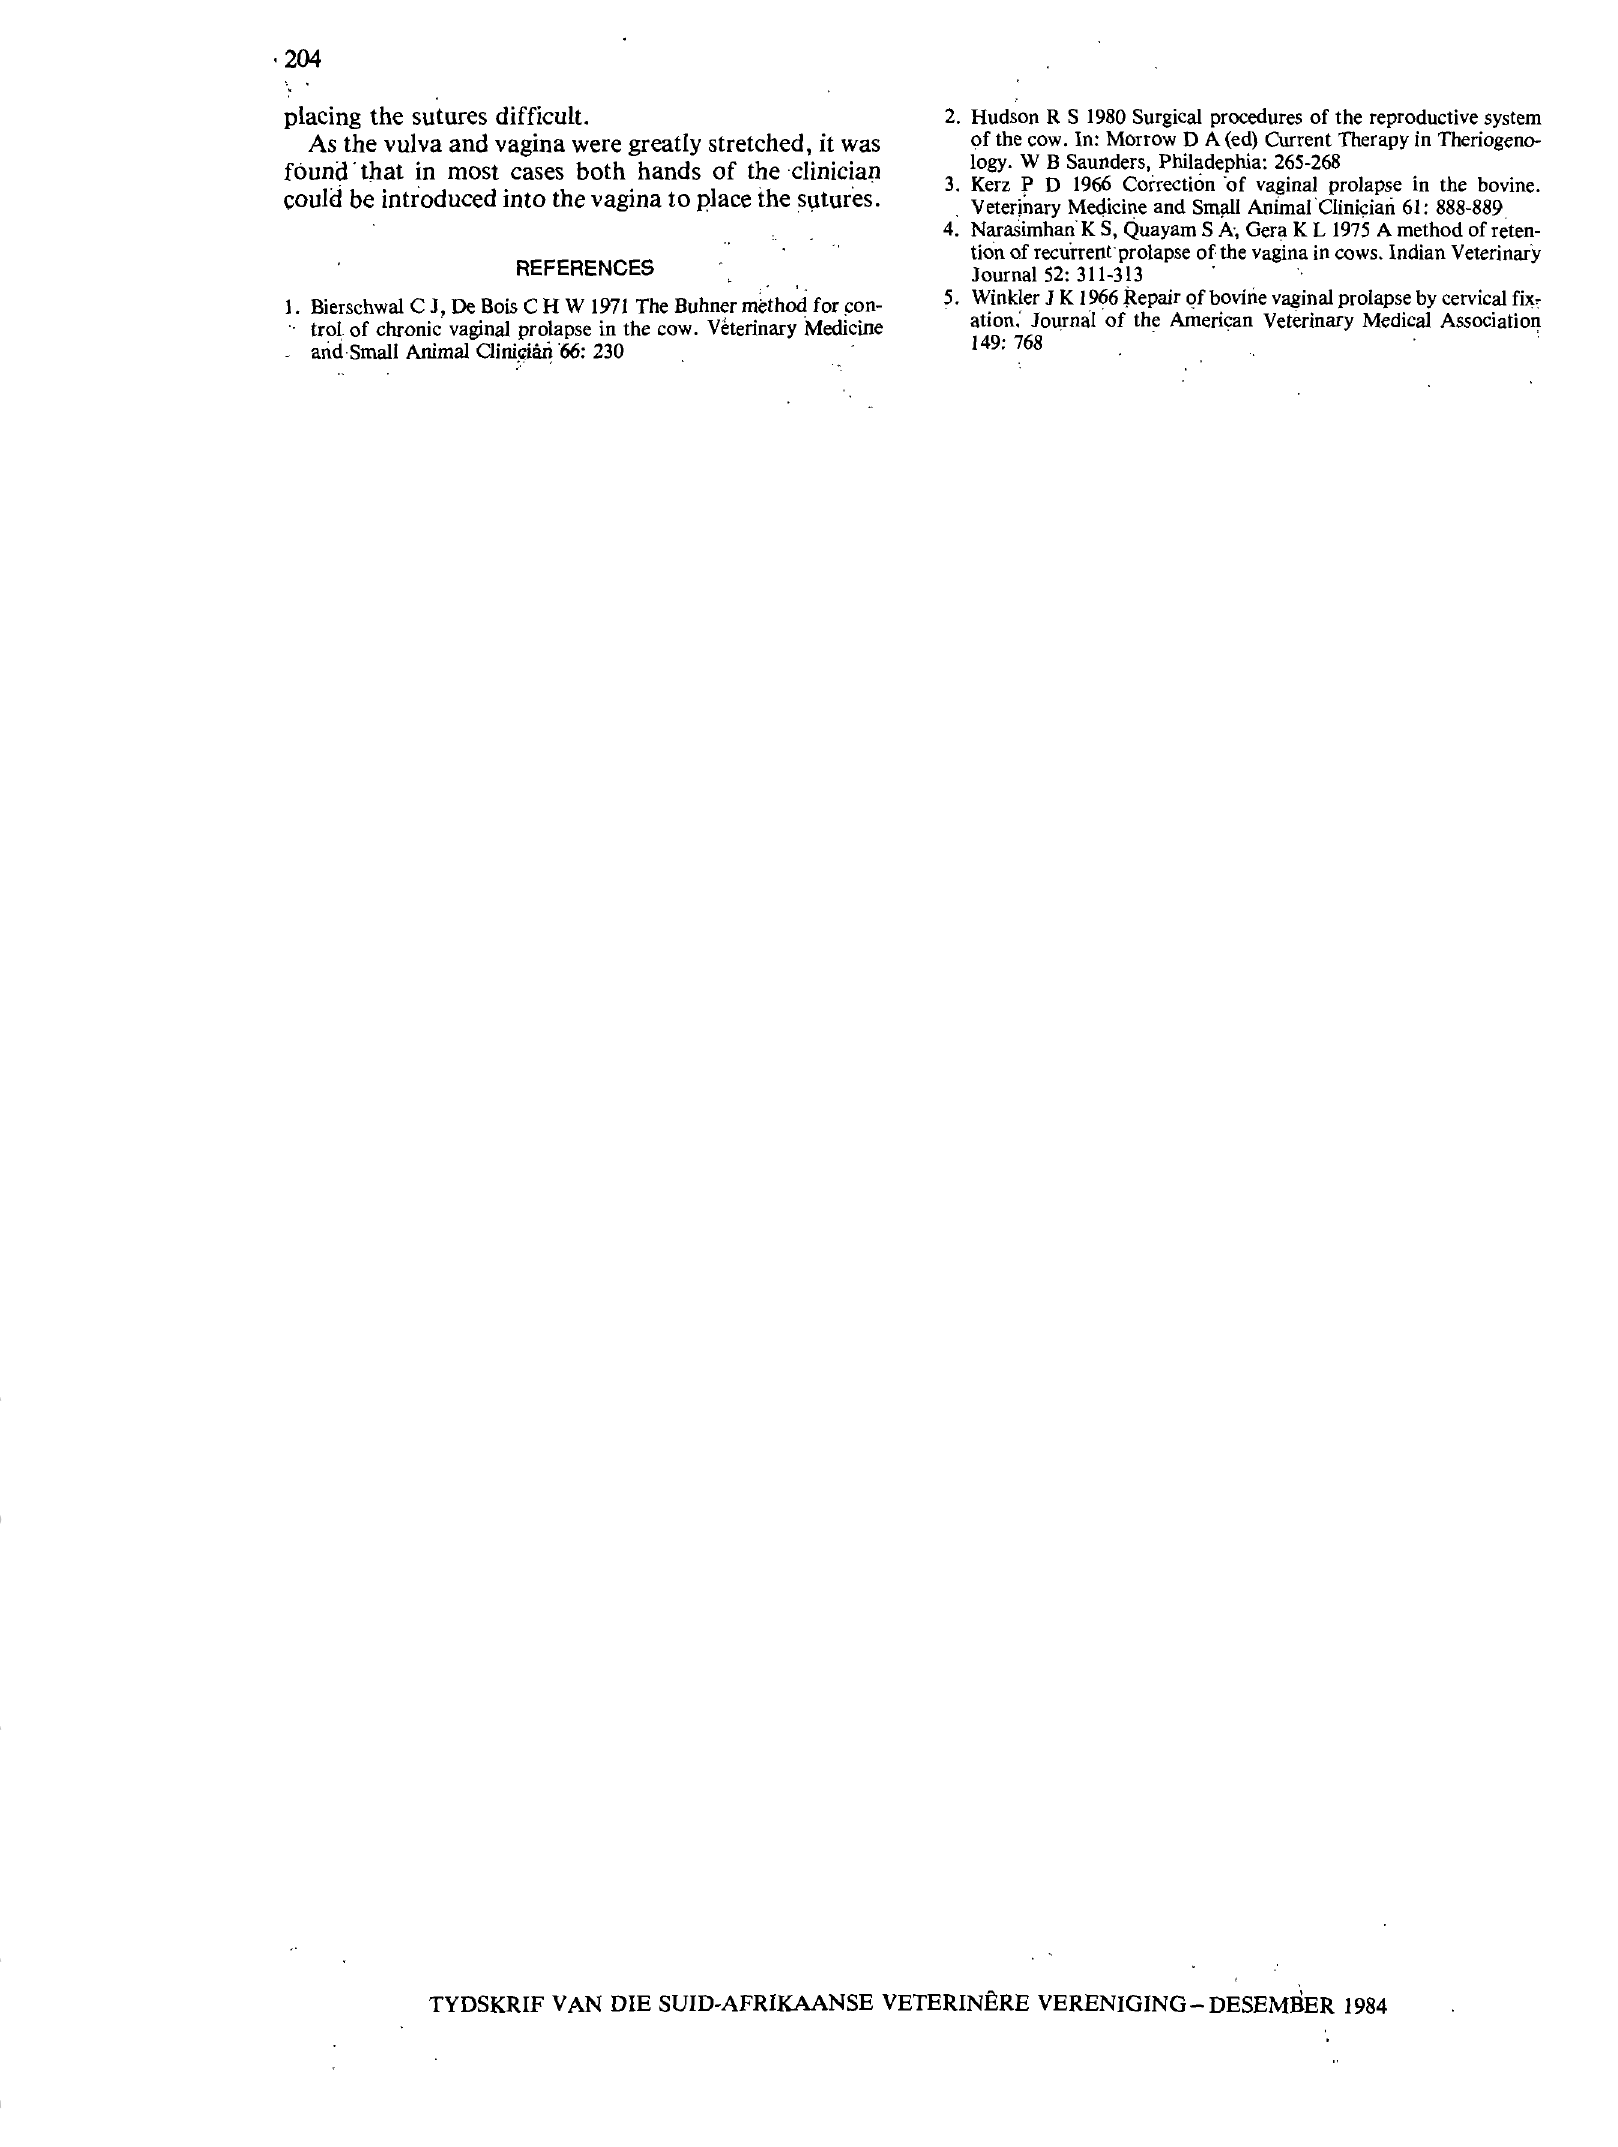
TYDSKRIF VAN DIE SUID-AFRIKAANSE VETERINERE VERENIGING-DESEMJiER